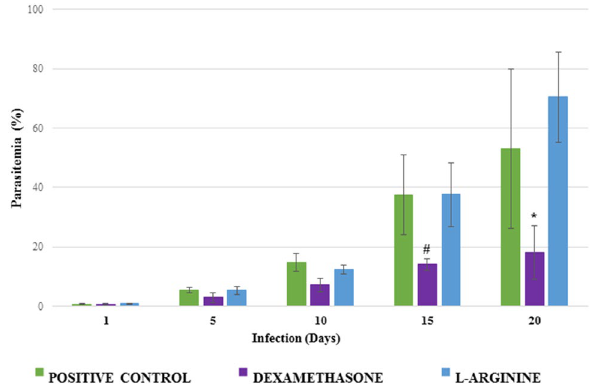
Figure 1. Progression of parasitemia in Plasmodium berghei -infected Swiss mice. Animals were pretreated and received a daily dose of DEXAMETHASONE, L-ARGININE, or PBS (CONTROL). # p = 6.8 × 10 −6 versus L-ARGININE and p = 7.3 × 10 −5 versus CONTROL; *p = 2.8 × 10 −5 versus L-ARGININE and p = 0.0227 versus CONTROL.